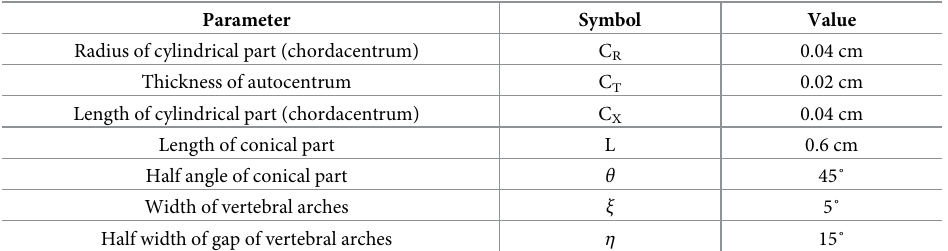
Table 1. Parameter settings to define geometry of analysis domain in Figs 2–6. Parameter Radius of cylindrical part